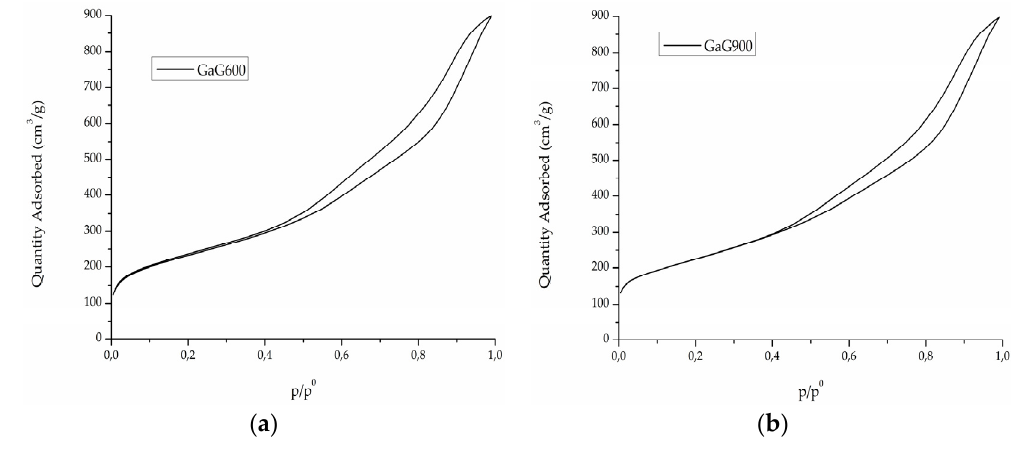
Figure 2. Isotherms of ( a ) GaG600 and ( b ) GaG900.